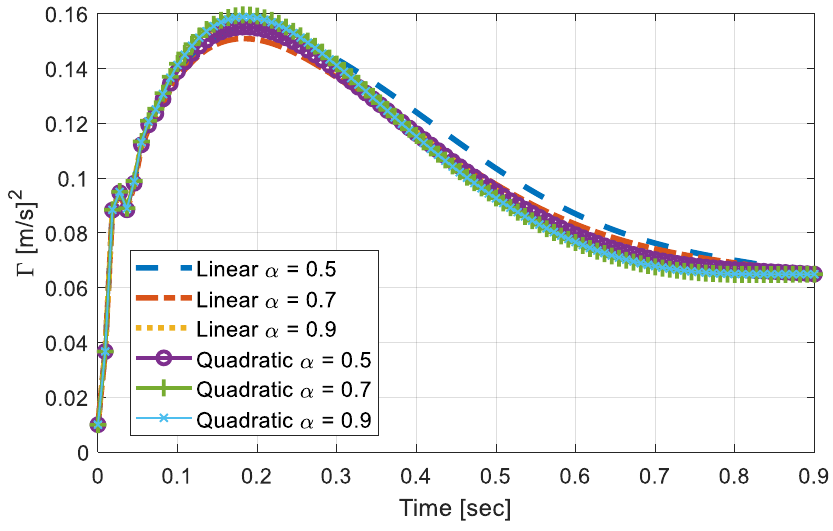
Figure 5. Covariance response on various foundation properties (without noise).